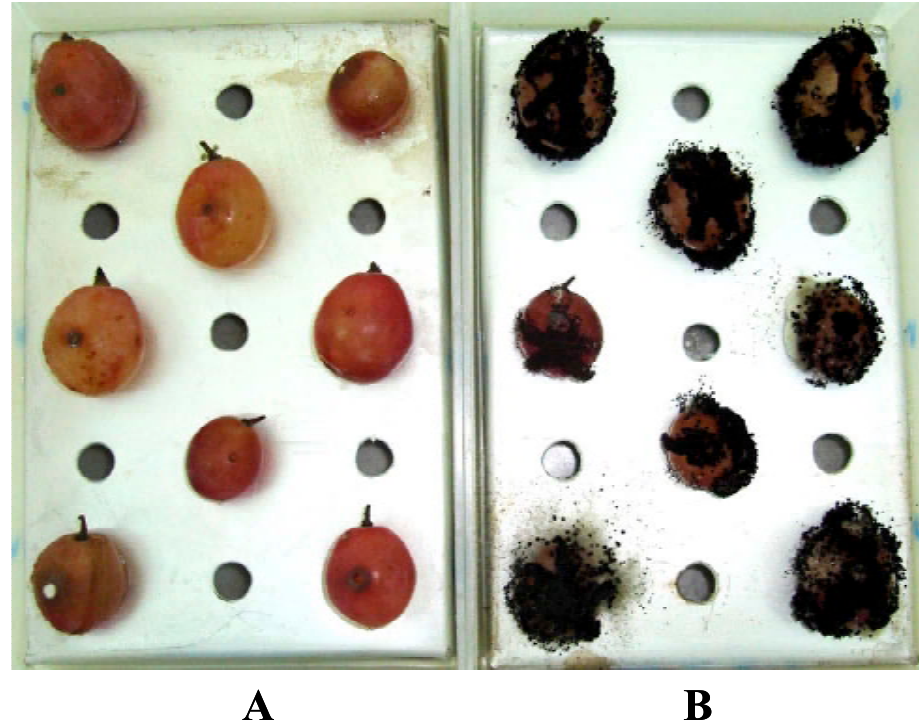
A B Figure 1. Biological control of Aspergillus carbonarius using the epiphytic yeast Aureobasidium pullulans on grape berries (cultivar “Fraoula”). A . Protection of berries treated with Aureobasidium pullulans strain Y1 (immersion in yeast suspension of 10 7 cfu mL -1 ) and 24h later infection with Aspergillus carbonarius. B . Control berries infected with Aspergillus carbonarius (25 μl of 10 4 conidia mL -1 per berry) (Dimakopoulou et al ., 2008).